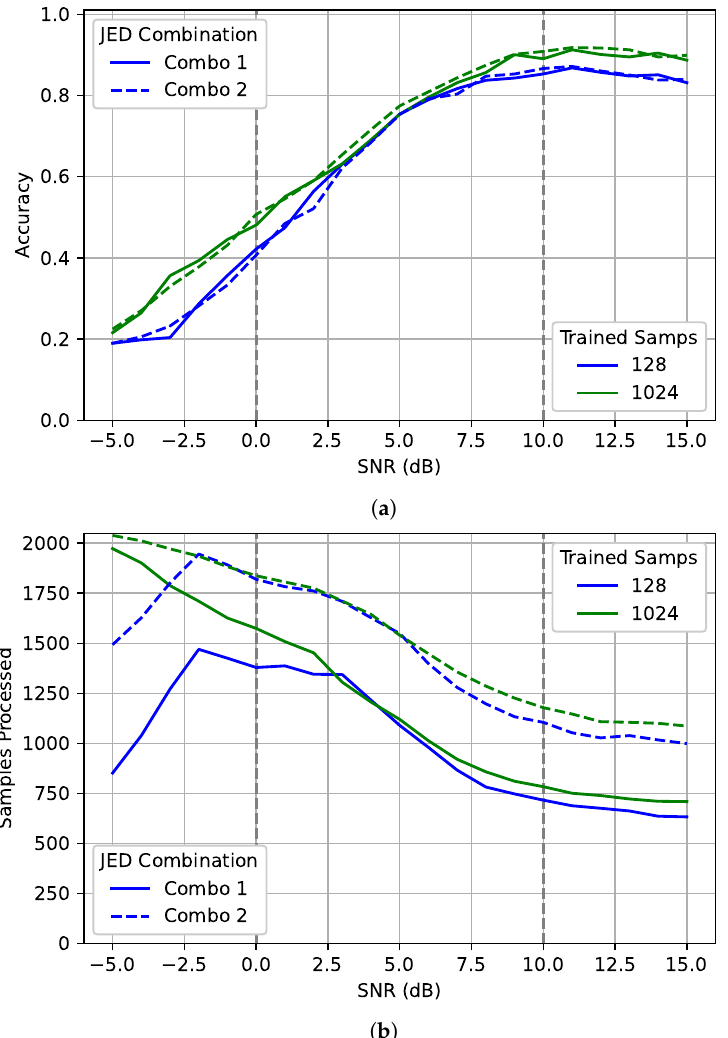
Figure 14. An examination of ( a ) accuracy and ( b ) the number of samples processed of JED for different SNRs. The best model for 128 and 1024 are each shown after processing with two different JED combinations. The gray dotted lines show the training range for